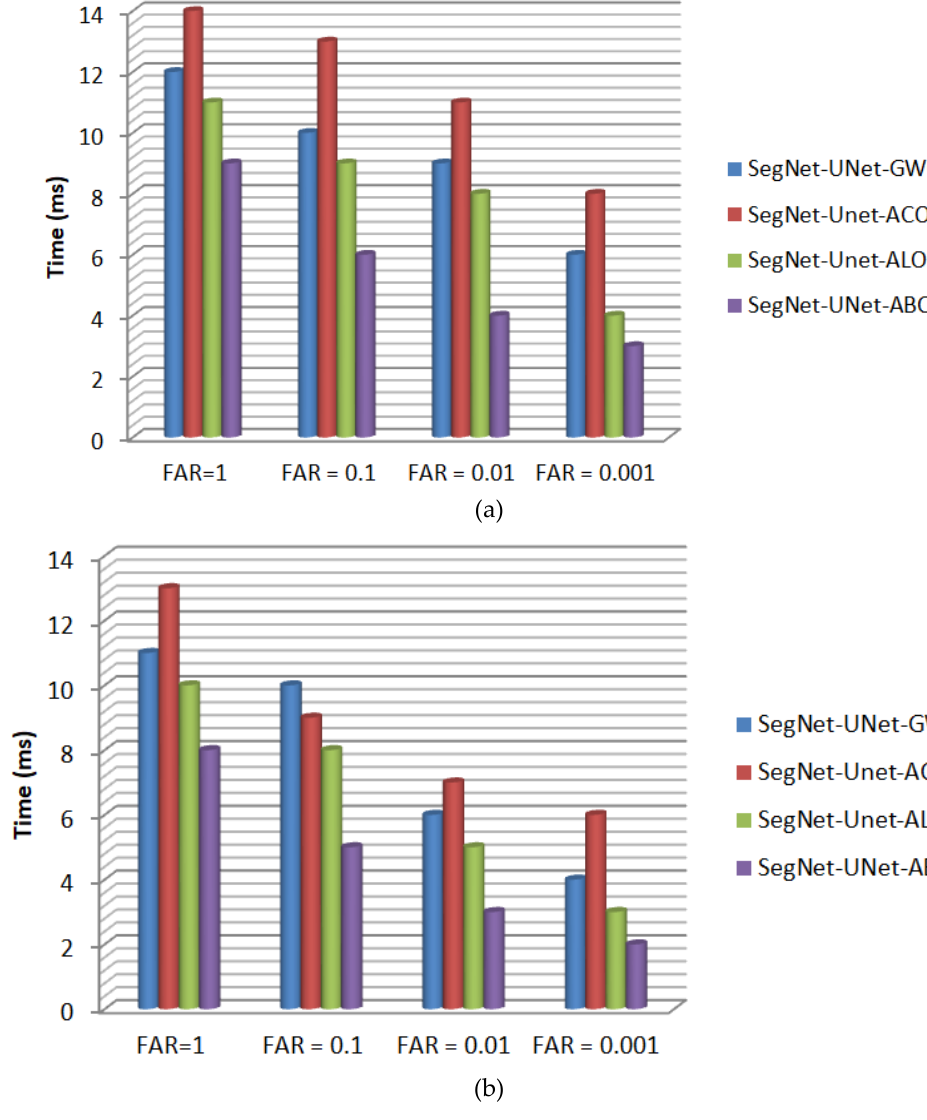
Figure 12. The convergence times obtained by all hybrid algorithms to segment liver lesions from the CT images using ( a ) the Radiopaedia dataset and ( b ) the LiTS dataset.